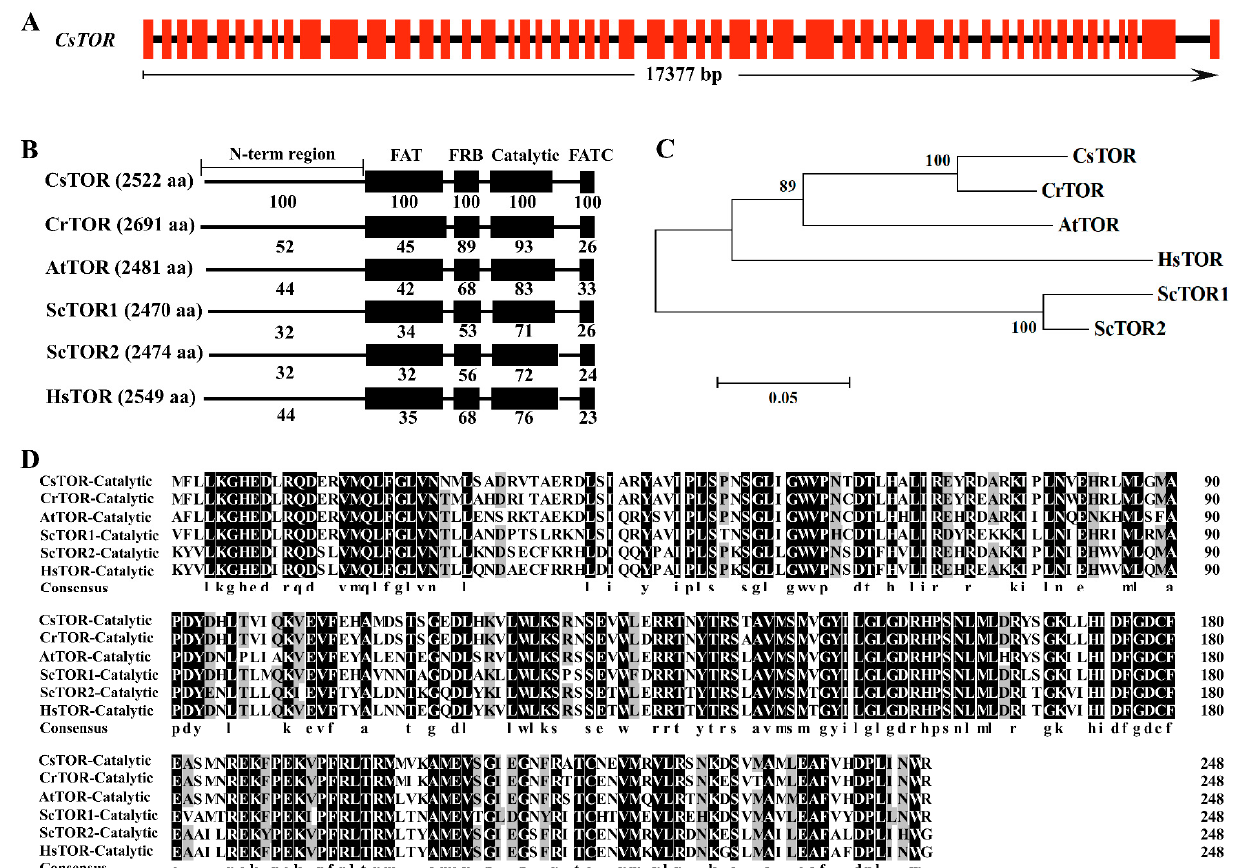
Figure 2. CsTOR structure and sequence analysis of Chlorella sorokiniana . ( A ) CsTOR gene sequence. The red rectangles represent exons. ( B ) The alignment of the CsTOR protein conserved domains with the TOR sequences of other species. The numerical value represents the similarity (%) of CsTOR protein sequence with that of other species, and the numbers in brackets represent the number of amino acids. Chlorella sorokiniana (Cs), Chlamydomonas reinhardtii (Cr), Arabidopsis thaliana (At), Homo sapiens (Hs), Saccharomyces cerevisiae (Sc). ( C ) Phylogenetic tree analysis of TOR protein sequences from Chlorella sorokiniana and other species. Phylogenetic tree generated from the neighbor-joining method (used MEGA 4 software, 1000 of bootstrap replicates) based on TOR protein sequences. ( D ) Sequence alignment analysis of the catalytic domain of CsTOR protein with that of other